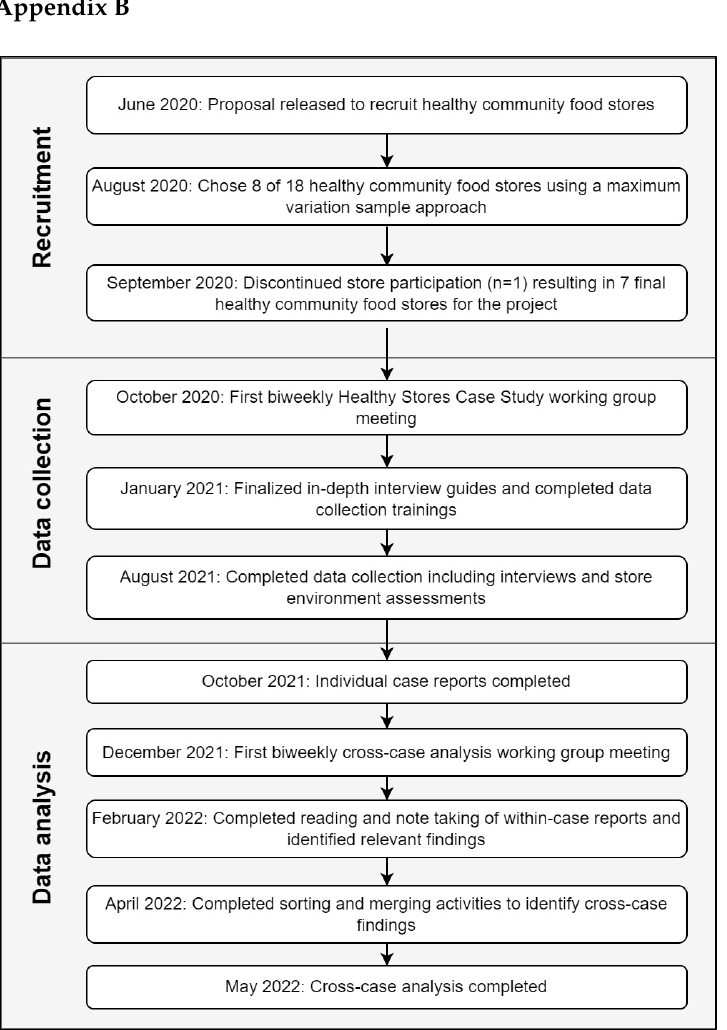
Figure A1. Study methodological flow diagram, including details from Gittelsohn et al., 2022 [31] .